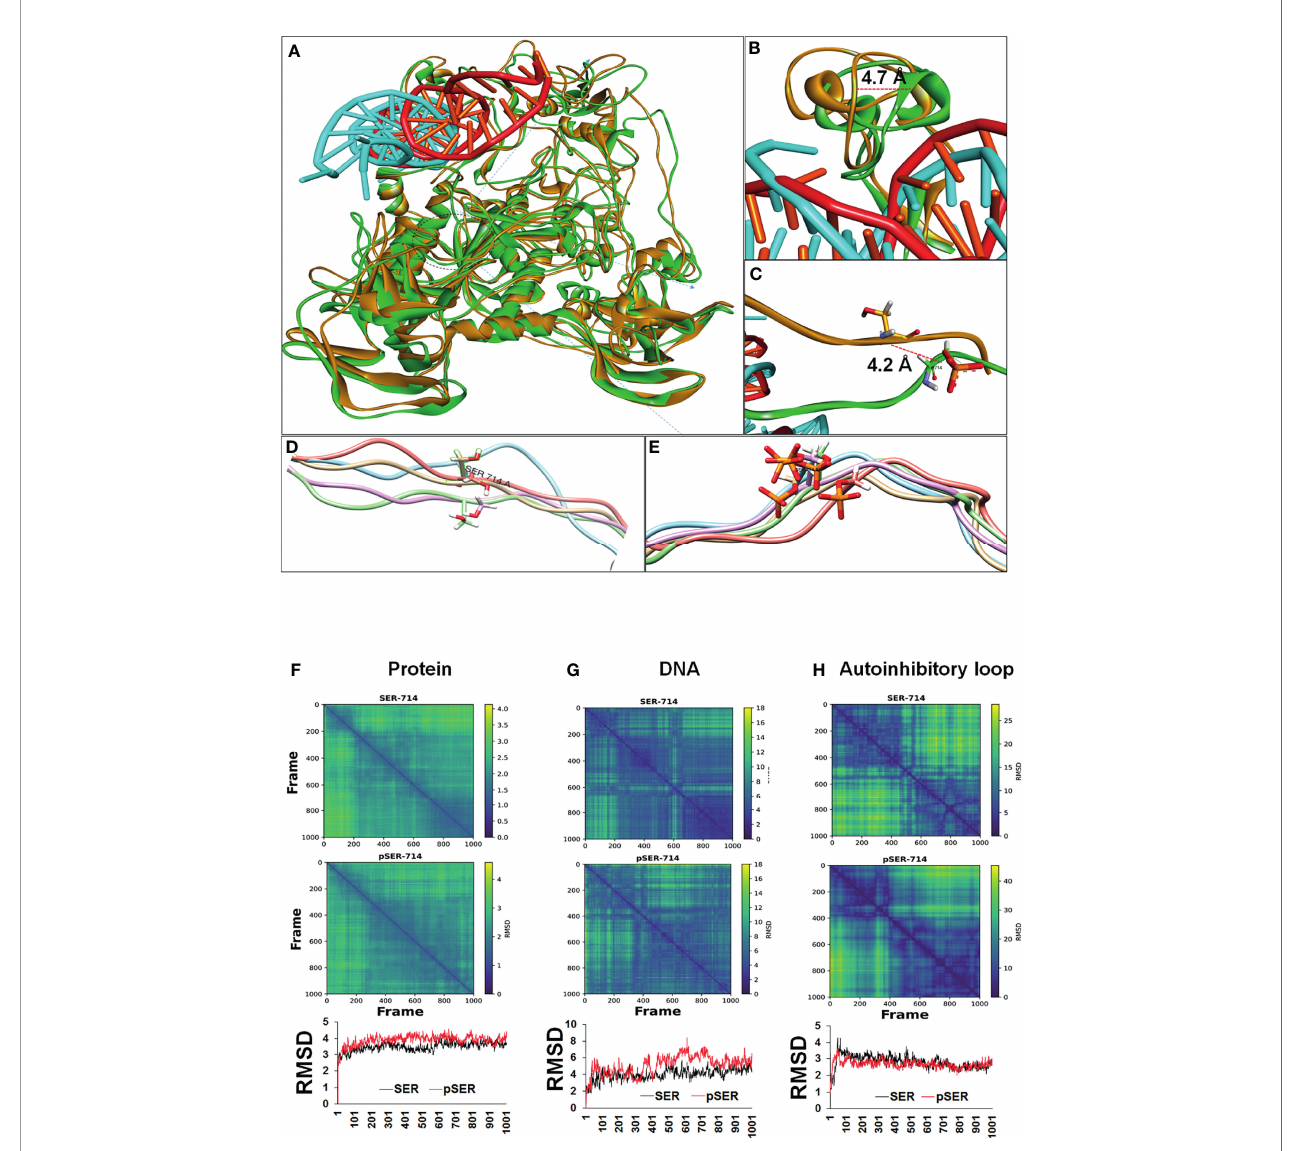
FIGURE 4 | Conformational changes resulting from phosphorylation of DNMT1 based on MD simulation. (A) Superimposed conformation of unphosphorylated (orange) and phosphorylated (green) protein-DNA complex at 80 ns. DNA (Cyan) bound with phosphorylated protein shows signi fi cant conformational changes. (B) The CXXC region (green) which holds DNA shows 4.7Å displacement in the phosphorylated protein. (C) After phosphorylation, the fl exible autoinhibitory domain was displaced by 4.2 (A, D, E) A zoomed image of the fl exible loop (20 AA) spanning phosphorylated residues shows stable conformation in the case of phosphorylated residue represented in stick model with orange color. (F-H) Diffusion map based on distance matrix and RMSD analysis. (F) The column represents global changes in the protein chain. No huge differences were observed, however, a relatively stable global conformation of phosphorylated protein was observed in comparison to unphosphorylated protein. (G) DNA bound with phosphorylated residue depicts large conformational changes followed by a stable state. (H) The local effect of phosphorylation shows a relatively stable conformation of the autoinhibitory loop (20 AA), which is involved in